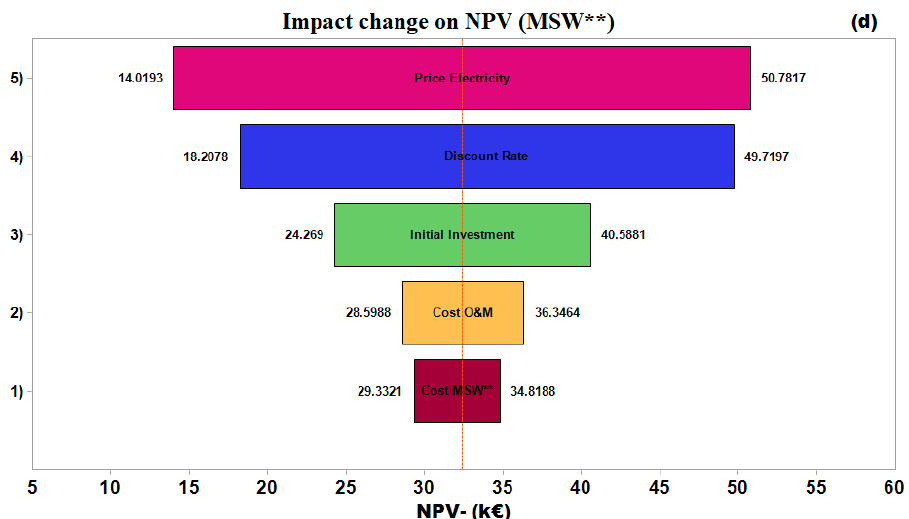
Figure 11. Sensitivity range to input variables for NPV for the different fuels: ( a ) acacia, ( b ) MSW *, ( c ) eucalyptus and ( d ) MSW **.